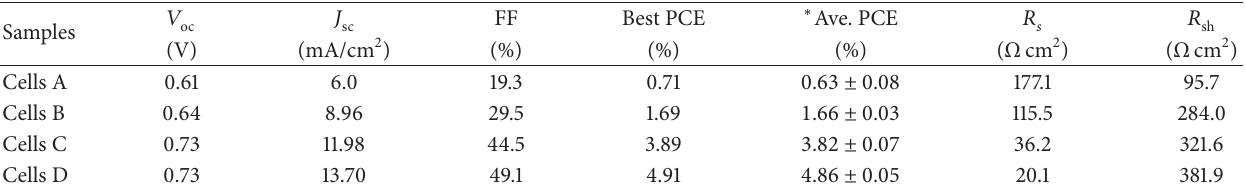
Table 1: Key photovoltaic parameters for the PSCs with various anode buffer layers under illumination 100mW/cm 2 AM 1.5G simulated solar light.